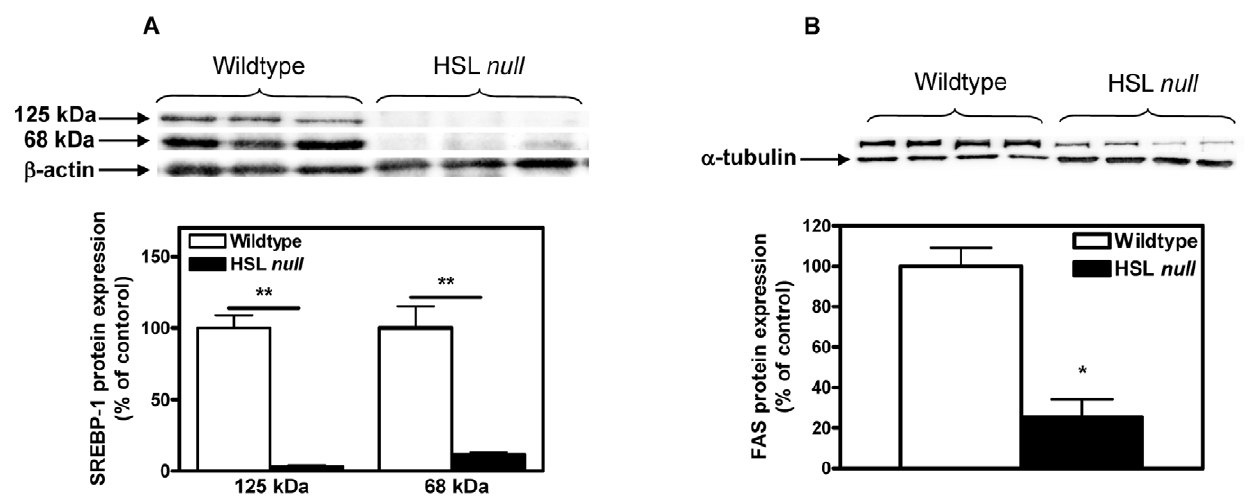
Figure 7. Decreased levels of lipogenic enzymes in WAT of HSL null mice fed a HFD. Protein levels of SREBP1 (A) and FAS (B), analyzed with western blot in WAT from 5 months old female wildtype and HSL null mice fed HFD (n=4–7). Values given are mean 6 SEM, *p , 0.05, **p , 0.01,